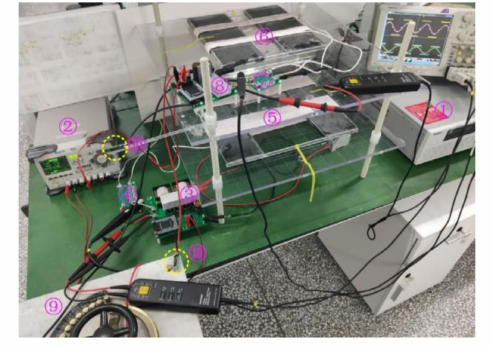
Figure 10. Photograph of the